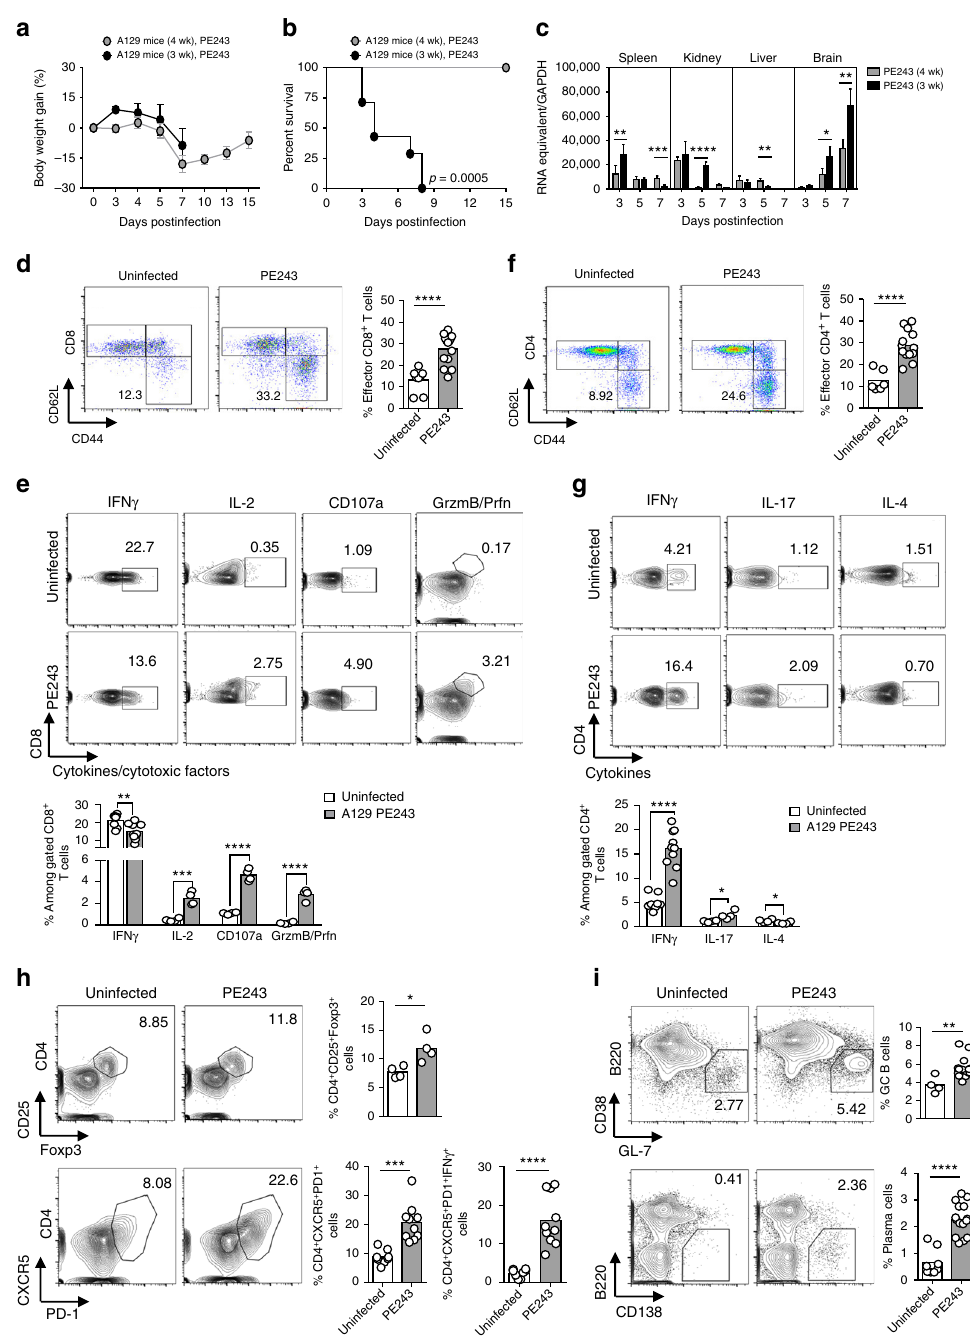
Fig. 1 A129 mice 4-week-old survive to ZIKV PE243 and evoke a robust immune response. Three- and 4-week-old A129 mice were inoculated intravenously with 2 × 10 5 PFU of ZIKV strain PE243. Uninfected mice were used as control. a , b Body weight gain ( a ) and lethality ( b ) of 3- ( n = 9) or 4-week-old A129 mice ( n = 15) infected with ZIKV PE243 were monitored for up to 15 days postinfection. c ZIKV RNA copies in the spleen, kidney, liver, and brain determined by qRT-PCR at days 3, 5, and 7 postinfection of 3- ( n = 3 – 8) or 4-week-old mice ( n = 4 – 6). Results are expressed as RNA equivalent/copies and normalized by GAPDH. Flow cytometry were performed on splenocytes from uninfected ( n = 4 – 8) or 4-week-old mice at day 7 postinfection ( n = 4 – 15). For cytokines and cytotoxic factors detection, splenocytes were restimulated in vitro with PMA and ionomycin in the presence of brefeldin A during 4 h. d Representative dot plot and frequency of CD62L − CD44 + (effector) among CD8 + . e Representative counter plot and frequency of IFN γ , IL-2, CD107a, granzyme B (GrzmB), and perforin (Prfn) among CD8 + T cells. f Representative dot plot and frequency of CD62L - CD44 + (effector) among CD4 + . g Representative counter plot and frequency of I IFN γ , IL-4, and IL-17 among CD4 + T cells. h Representative counter plot and frequency of CD25 + Foxp3 + or CXCR5 + PD-1 + and CXCR5 + PD-1 + IFN γ + among CD4 + T cells. i Representative counter plot and frequency of germinal center B cells among B220 + CD138 − and plasma cells. Results are shown as mean in d – i or as mean ± standard deviation in a and c . Data are representative of two independent experiments in a , b , and c , data are presented as a pool of two or three independent experiments in d – i . Survival data were analyzed by log rank test. Data were analyzed by Student ’ s t test in c – i. * p ≤ 0.05; ** p ≤ 0.01; *** p ≤ 0.001; **** p ≤